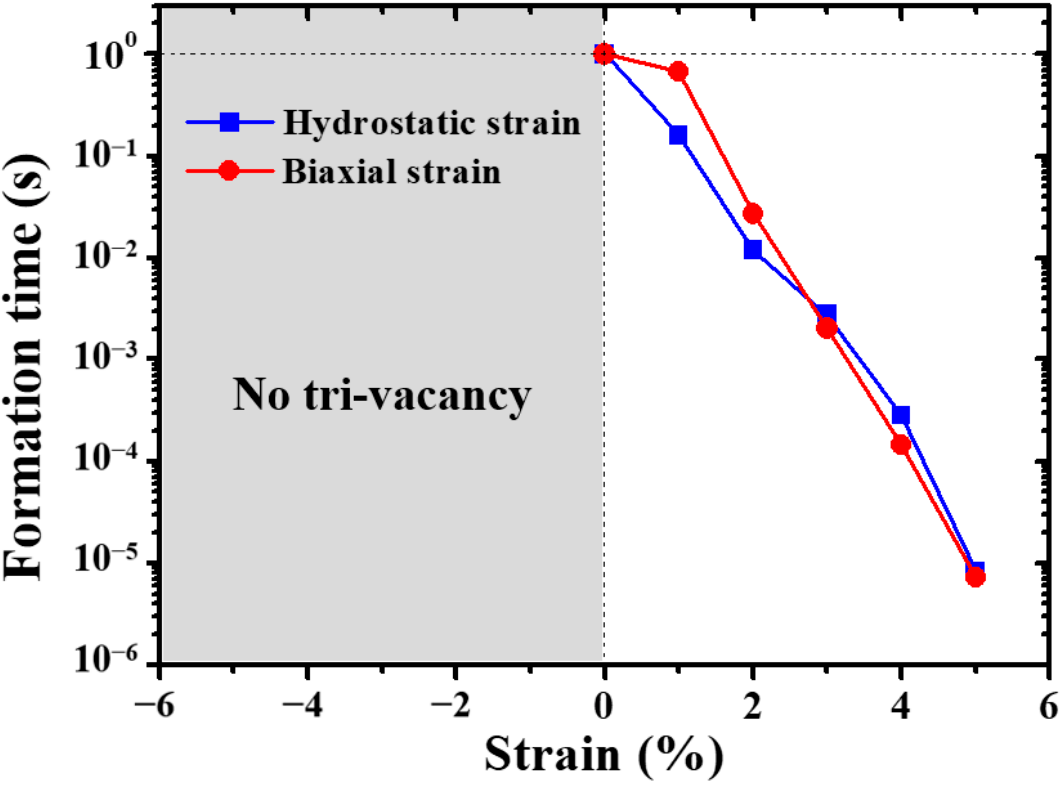
Figure 11. The formation time of tri-vacancy under both hydrostatic and biaxial strains in W.